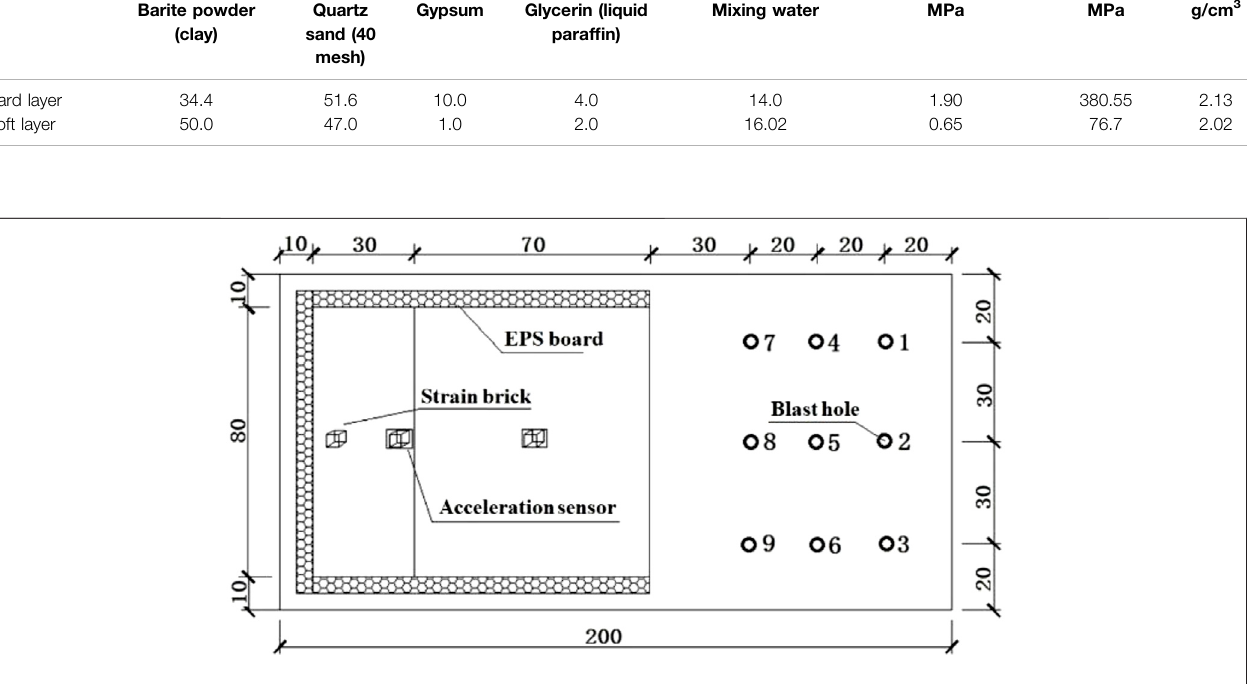
FIGURE 1 | Plan fi gure of the test model.